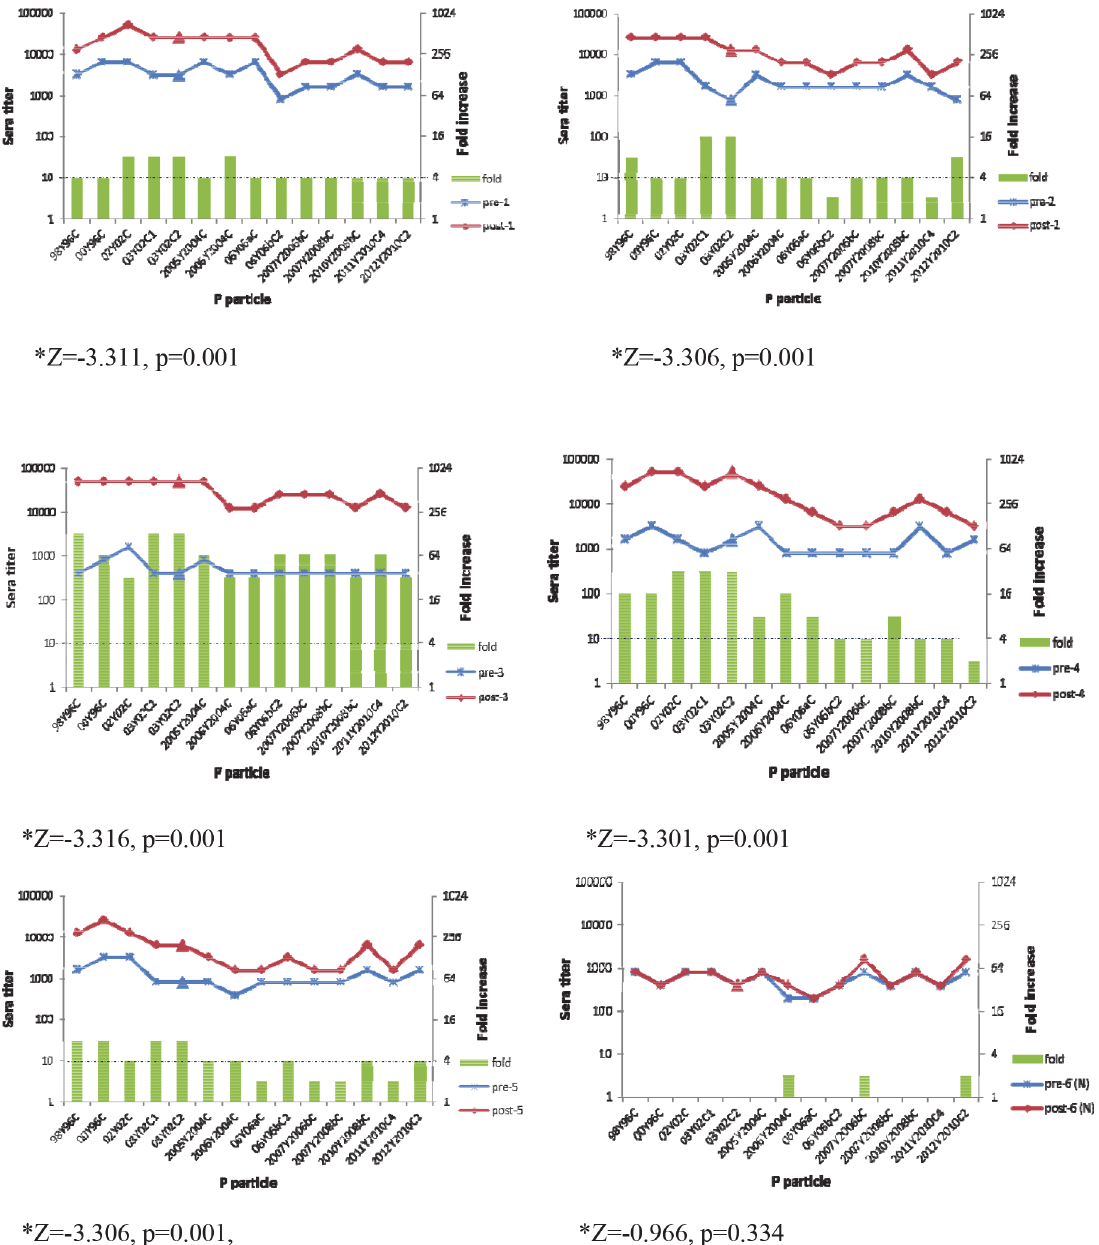
Fig 6. Human sera IgG responses from GII.4 NoV challenge study (03Y02C2, cluster 2002) to GII.4 P particles of different clusters from 1998 to 2012. Pre- (day 0) and post- (day 30) serum samples were collected during a human challenge study. P particles (98Y96C, 00Y96C, 02Y02C, 03Y02C1, 03Y02C2, 2005Y2004C, 2006Y2004C, 06Y06aC1, 06Y06bC2, 2007Y2006bC, 2007Y2008bC, 2010Y2008bC, 2011Y2010C4, and 2012Y2010C2) were coated at 0.5 μ g/ml. The fold increases from pre- to post- challenge phase serum in IgG titers (green columns) were determined (right-hand y-axis), and the dashed line indicates fold increases of (cid:1) 4. Serum from a non-secretor after GII.4 NoV challenge was set as the control; homology responses to 03Y02C2 are shown with triangle marker. Significant increases (p < 0.05) in blocking titer between pre- and post-challenge sera samples were determined for different P particles using the Wilcoxon